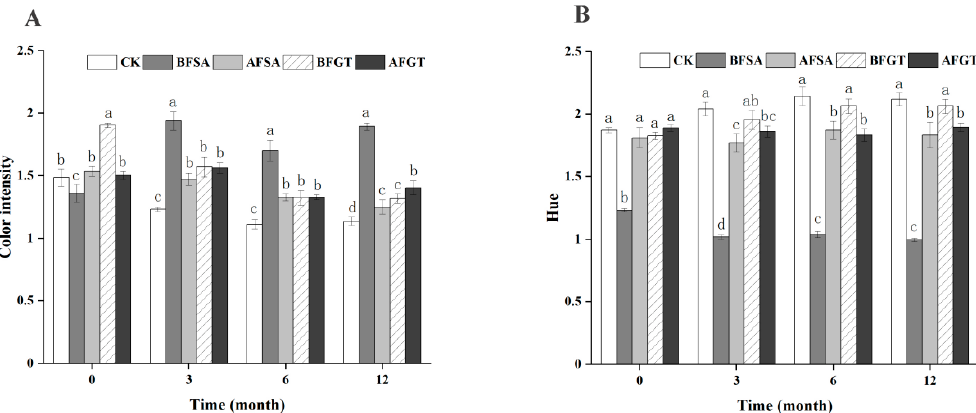
Figure 3. Effects of added sinapic acid and grape tannin on the color intensity ( A ) and hue ( B ) of cherry wine. Samples with different letters are significantly different ( p < 0.05).